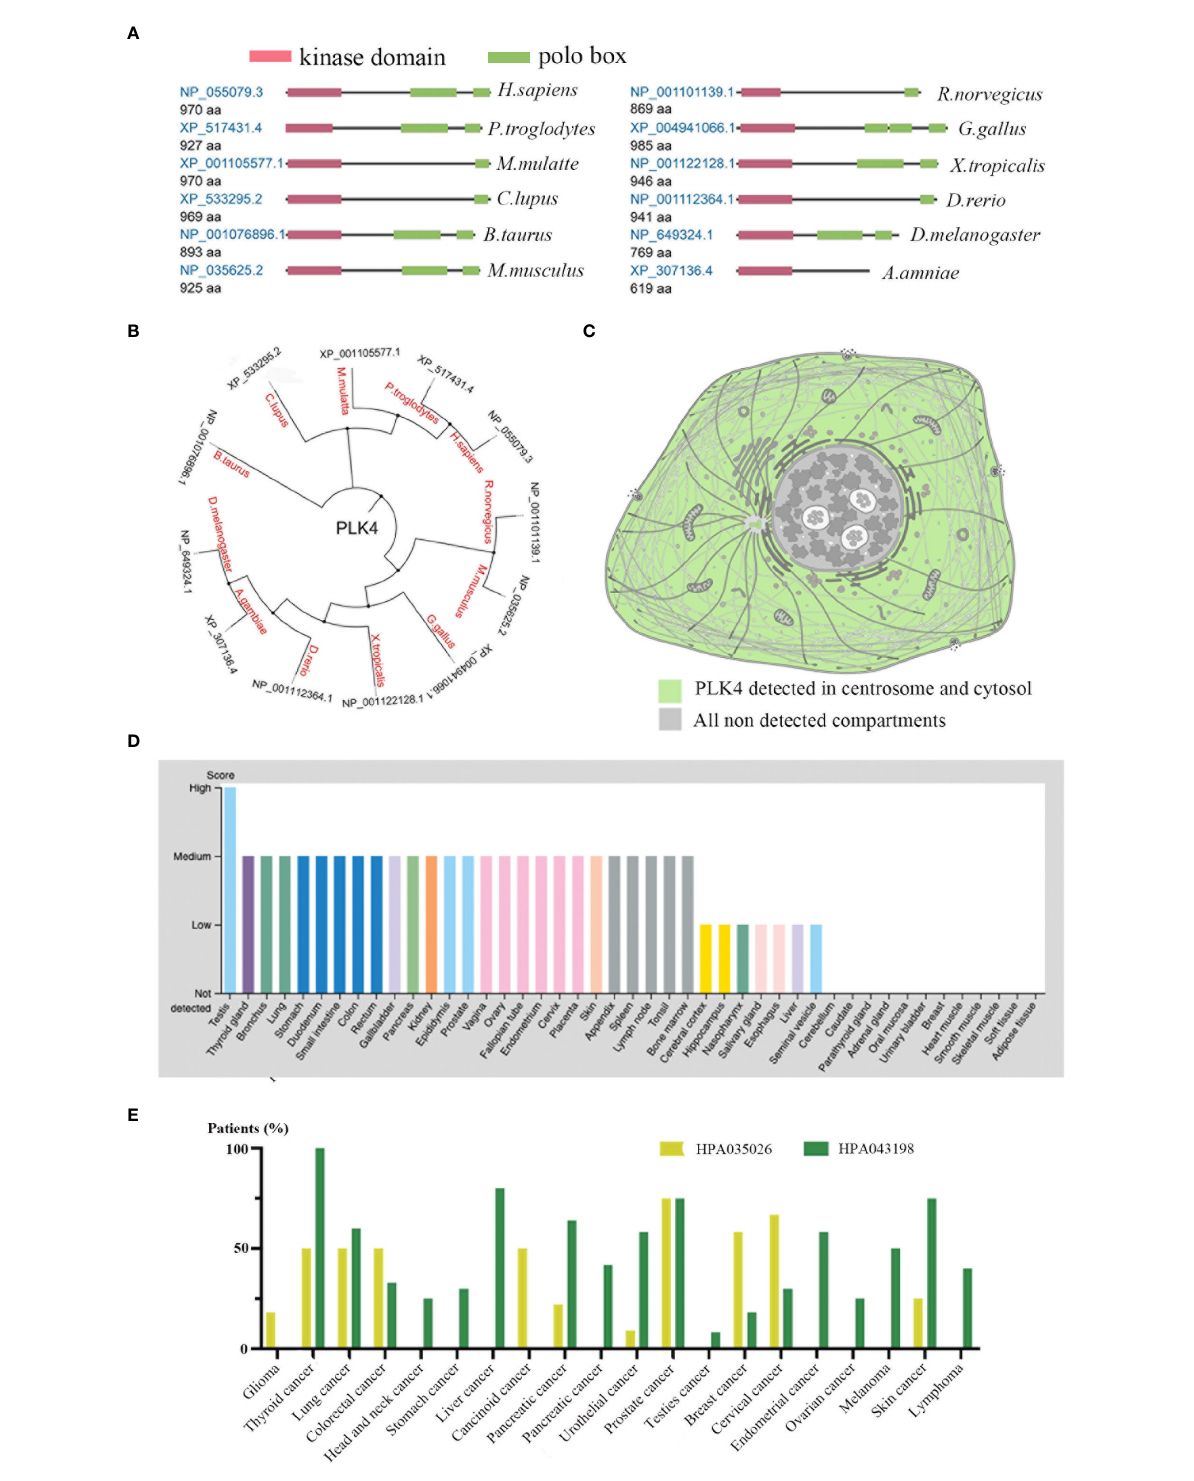
FIGURE 3 Expression levels of PLK4 protein in different normal tissues and tumors. (A) Conserved domains in the PLK4 protein structure among different species. (B) Phylogenetic tree for PLK4 protein across different species. (C) Subcellular localization of PLK4 protein in cells. (D) PLK4 protein expression levels across normal tissues were analyzed in HPA. (E) PLK4 protein expression levels in various cancer types were analyzed by immunohistochemistry staining using two antibodies (HPA035026, HPA043198) in